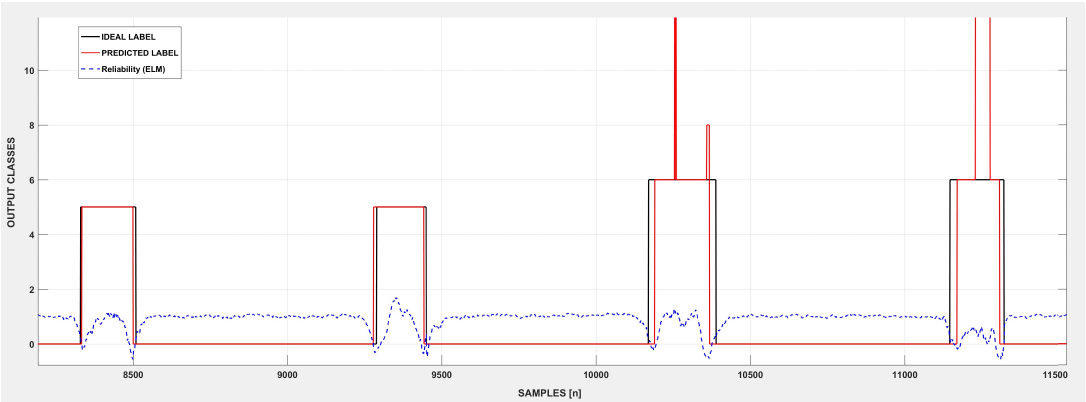
Figure 6. An example of the reliability metric in the ELM classifier: The solid black line provides the ideal label of the output class. The solid red line provides the predicted class, while the blue dashed curve represents the reliability of the system for each classification performed. Classification errors tend to occur when the reliability metric drops, which indicates the non-reliable classifications, which can be autonomously identified by the